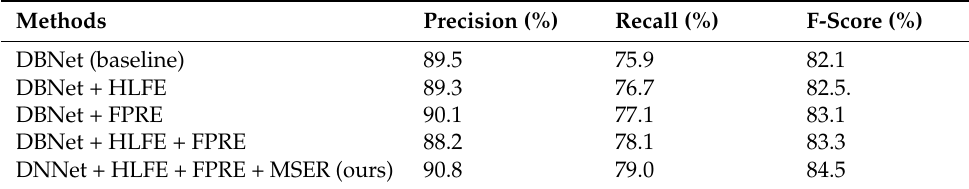
Table 3. Comparison of results of ablation experiments on the ICDAR2015 dataset.